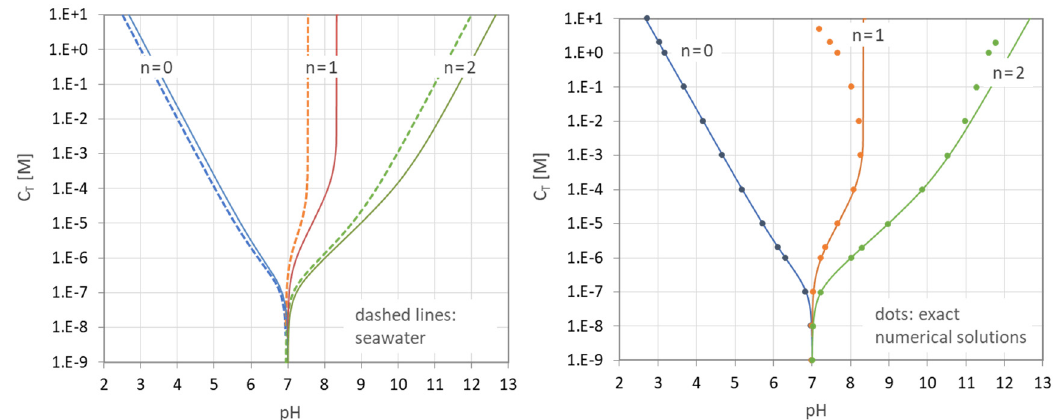
Figure 33. pH–C T diagrams of the carbonic-acid system. ( Left) : H 2 CO 3 in pure water (solid lines) vs. H 2 CO 3 in seawater (dashed lines). ( Right) : closed-form expression (117) vs. numerical model (dots).